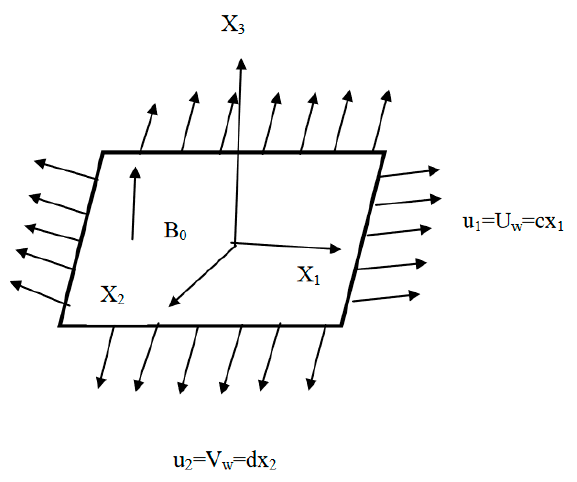
Figure 1. Physical model of the problem.